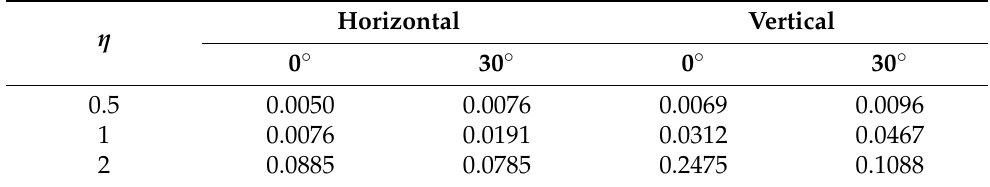
Figure 4. Coefficient of variation of surface displacement amplitude values for 100 sets of porosity samples. ( a ) Coefficient of variation of horizontal displacement; ( b ) Coefficient of variation in vertical displacement. Table 1. Average variation coefficient of horizontal and vertical displacement amplitude (random